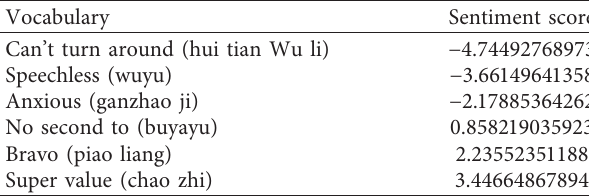
Table 3: Example of sentence sentiment score.